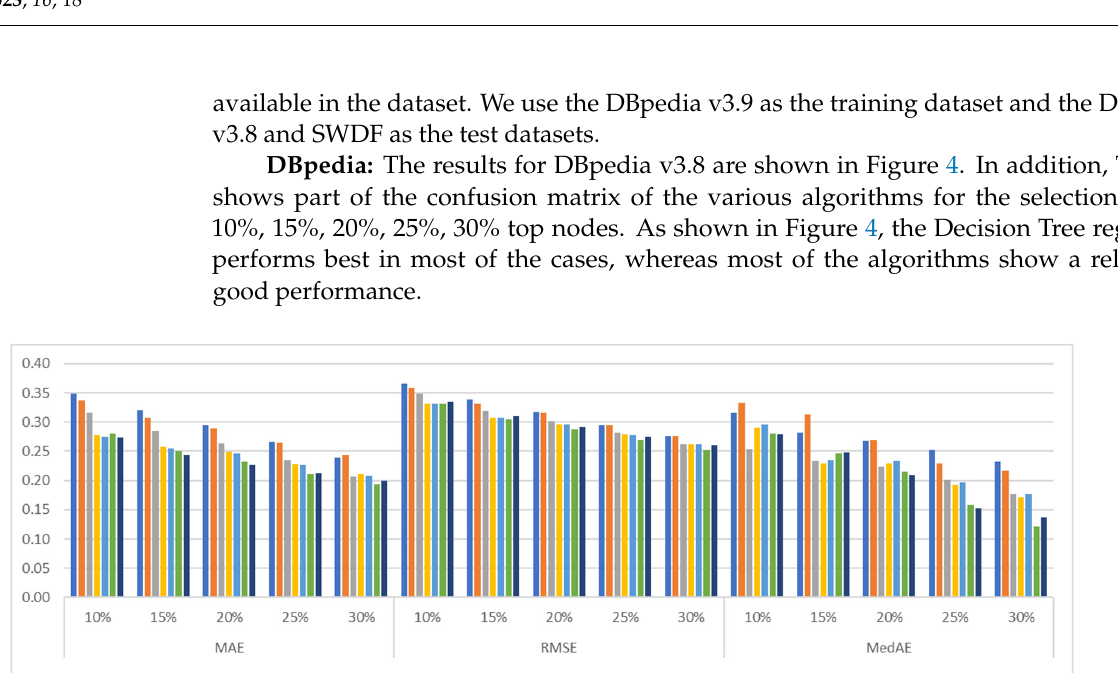
Table 6. TP for test results of DBpedia v3.8 (Predicted Nodes/Actual nodes).